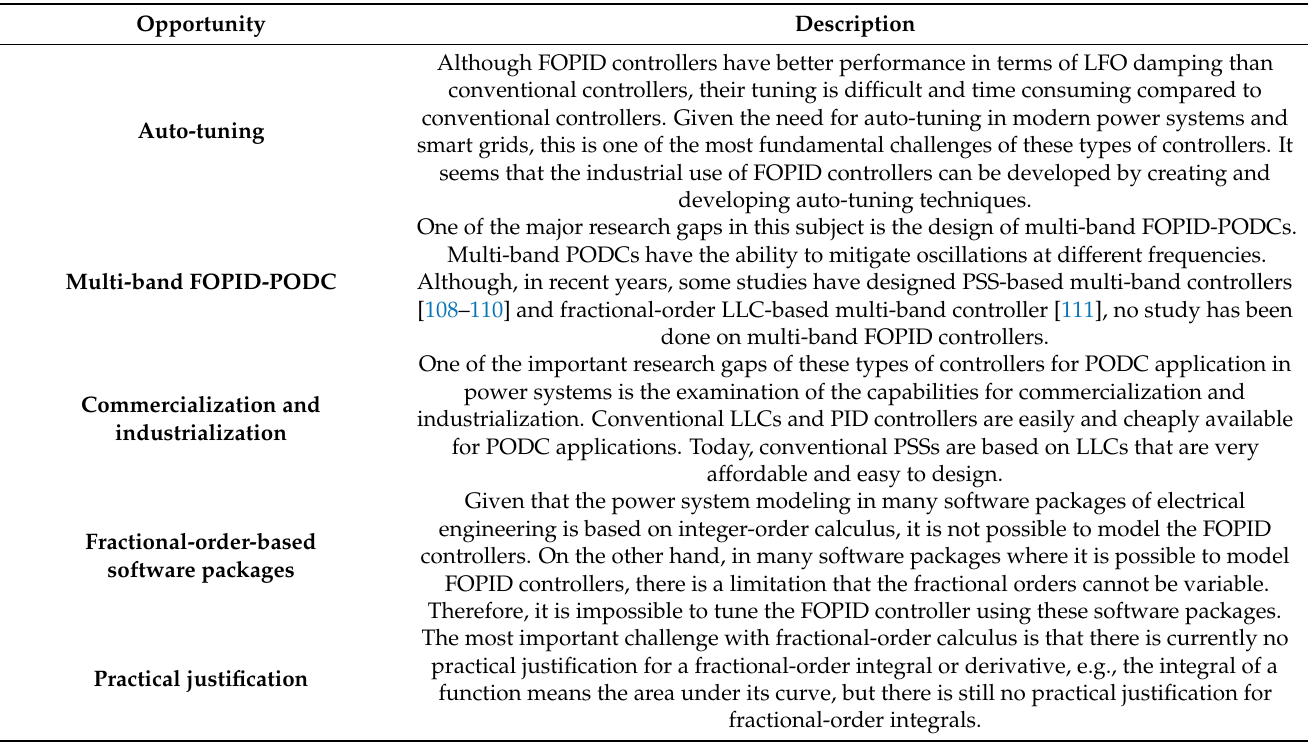
Table 11. Research gaps and challenges of the FOPID controller for LFO mitigation in power systems.